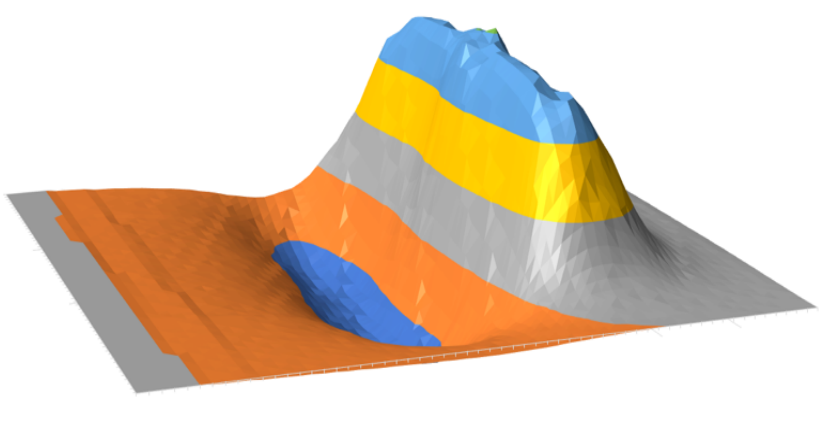
Figure 5. A 3D image of the model tsunami source used for numerical modeling; see [5].